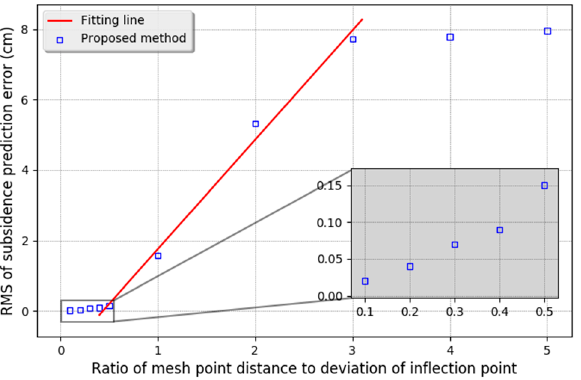
Figure 10. Scatterplot of RMS of the proposed method-based subsidence prediction errors versus ratio of mesh size to deviation of inflection point of the mining area. Table 2. Mean, STD and RMS of the proposed method-based subsidence estimation errors under different ratios of mesh size to deviation of inflection point.